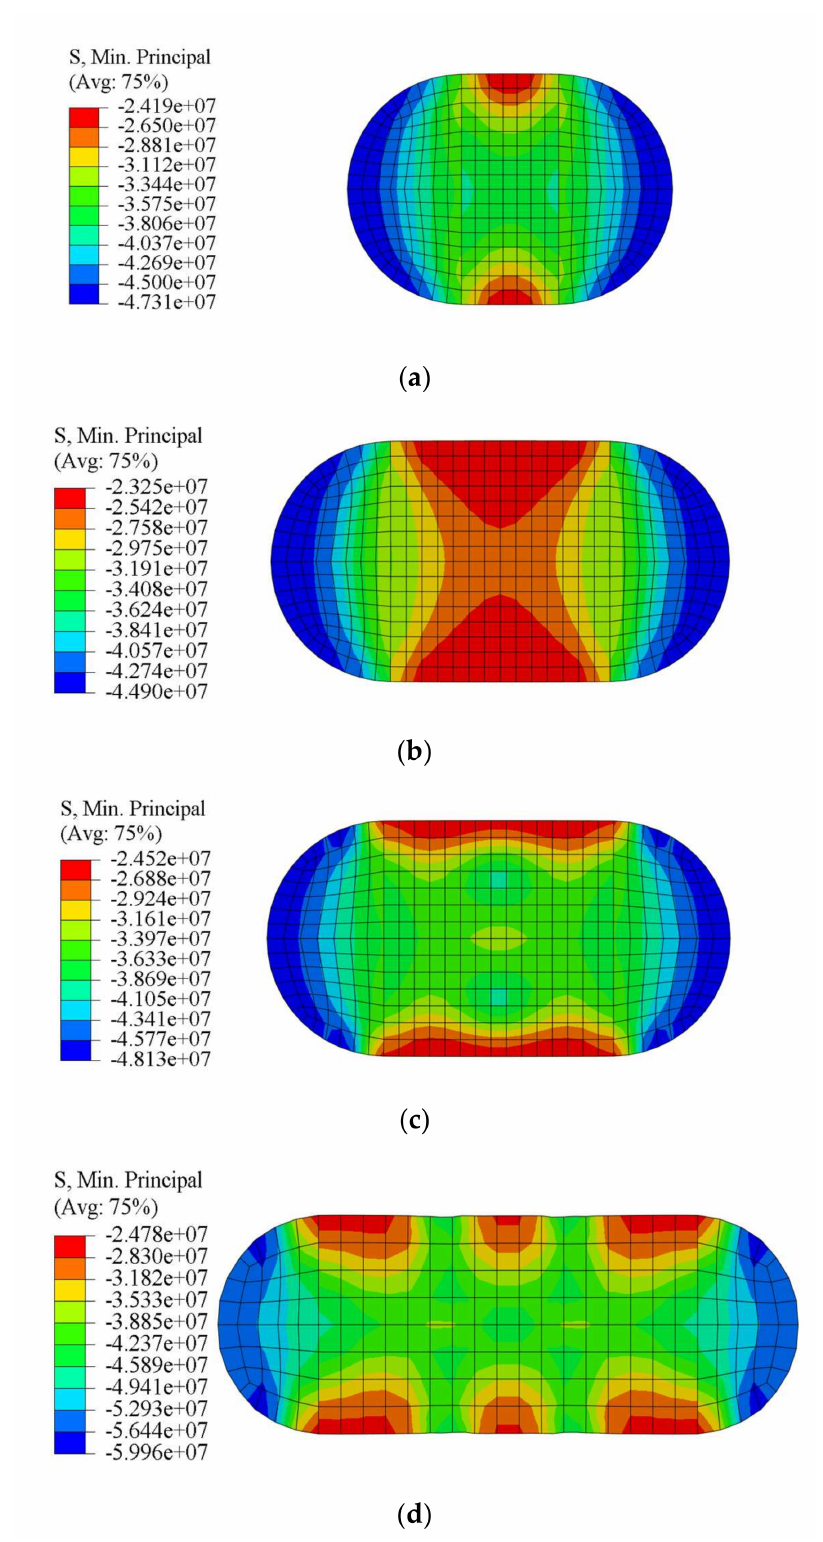
Figure 11. Stress diagram at mid cross-section of some specimens: ( a ) RRCFST-1; ( b ) RRCFST-3; ( c ) RRCFST-4; ( d )